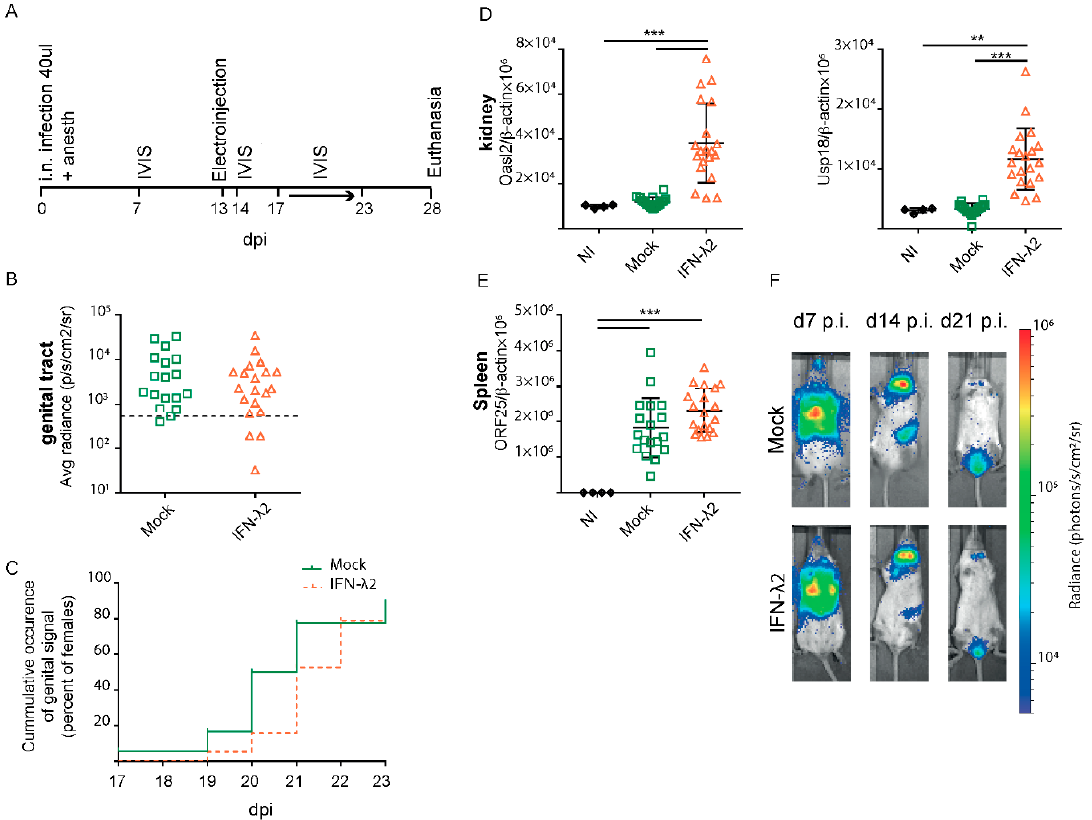
Figure 6. MuHV-4 reactivation in the genital tract despite IFN- λ treatment. ( A ) Same experiment